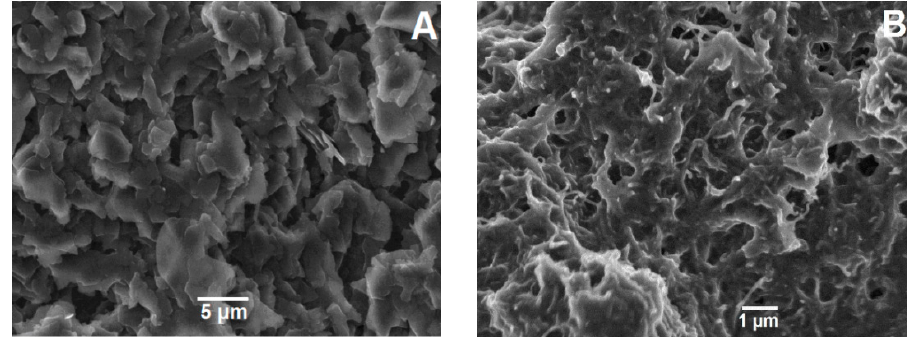
Figure 1. SEM images of bare CPE ( A ) and CPE/MWCNTs ( B ) surfaces.